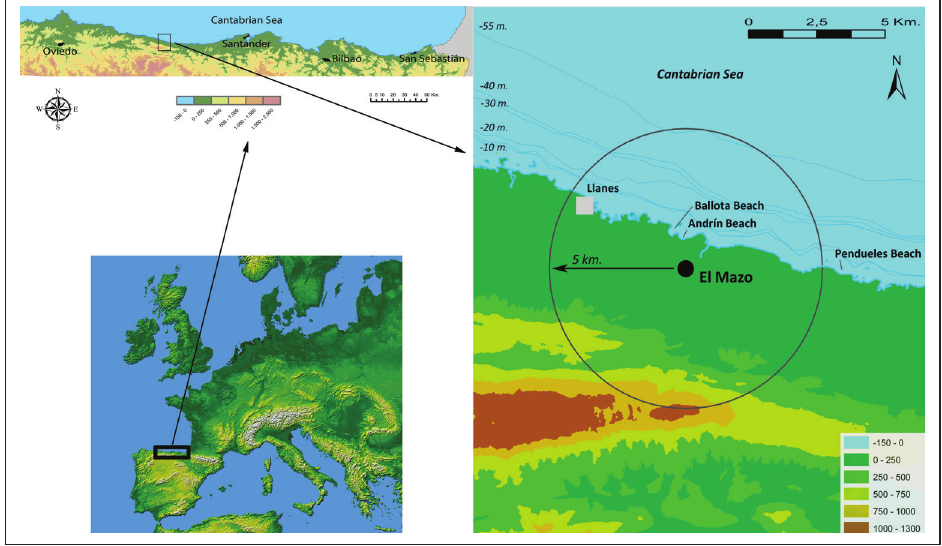
Figure 1: Localization of El Mazo shell midden site and the study